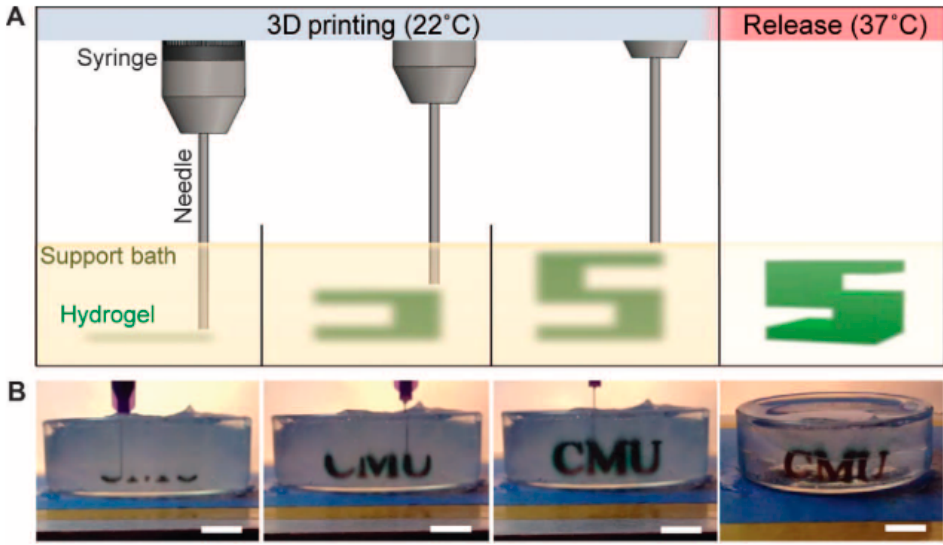
Figure 14. FRESH technique. Injection of hydrogel ink into the support bath at 22 °C layer-by-layer ( A ). Example of letters “CMU” printed in alginate into a gelatin support bath (Scale bar is 1 cm) ( B ). Reprinted from Reference [39], with permission from Science